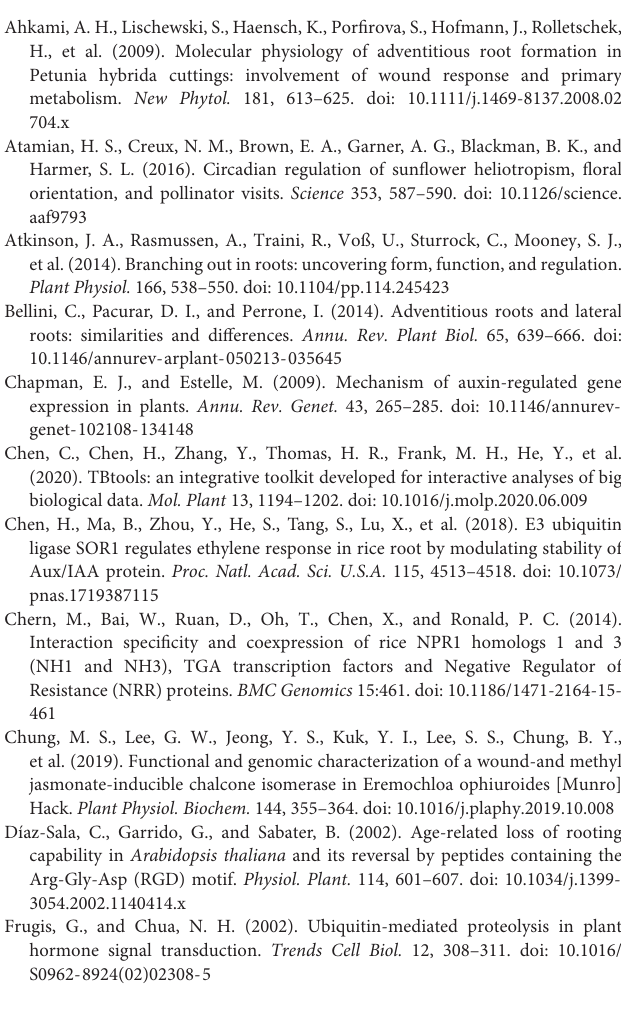
represent 100, 75, and 50% identity, respectively. Red asterisks represent different amino acid sites between A. thaliana and Poaceae plants. Supplementary Table 1 | Selected DEGs of centipedegrass root development. Supplementary Table 2 | Primer sequences. Supplementary Table 3 | Summary of transcriptome sequencing for centipedegrass E039 roots. Supplementary Table 4 | Top 30 enriched GO terms of DEGs in three comparisons. Supplementary Table 6 | Pathway classification of the upregulated and downregulated DEGs. Supplementary Table 7 | DEGs involved in plant hormone signal transduction. Supplementary Table 8 | DEGs of E3 ubiquitin-protein ligases. Supplementary Table 9 | DEGs of